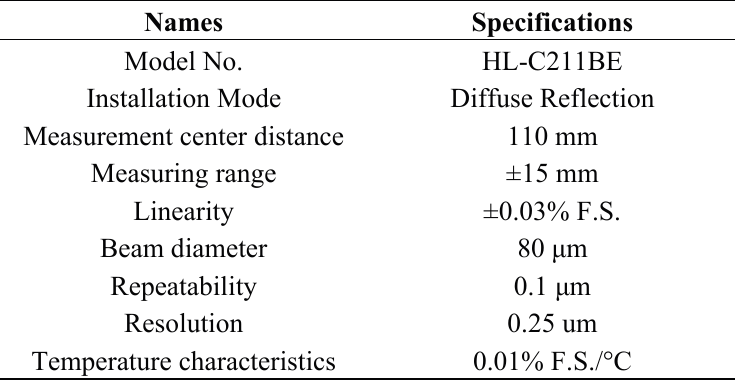
Table 1. The main parameters of the